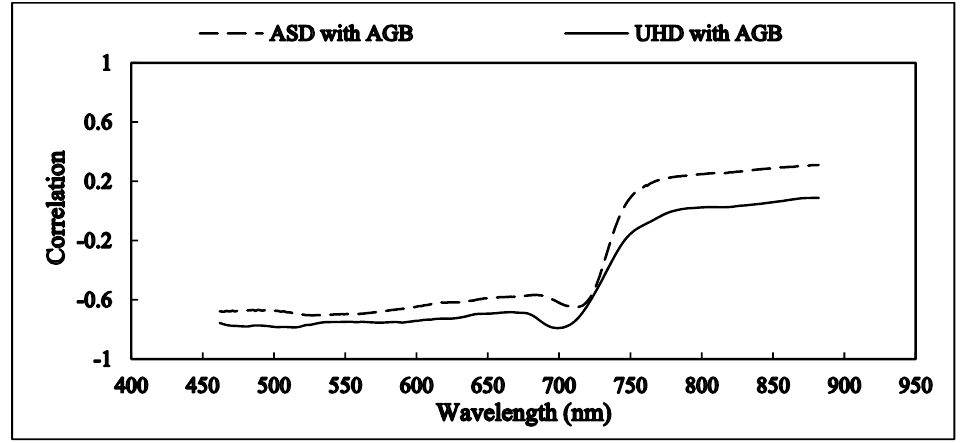
Figure 6. Correlation analysis between ASD spectral reflectance with AGB, UHD 185 spectral reflectance with AGB.